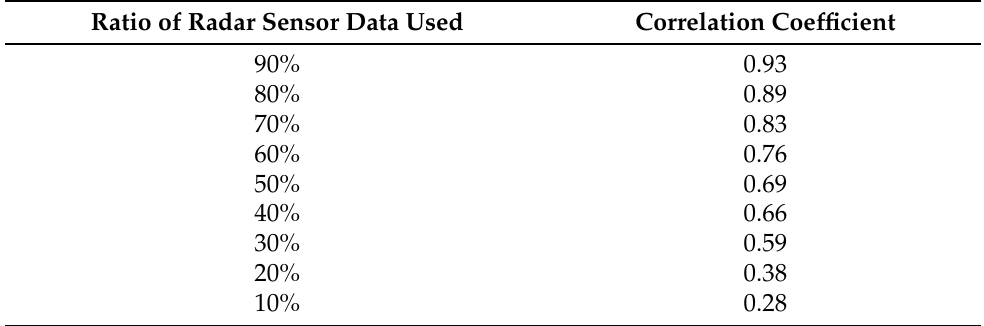
Table 2. Pearson correlation coefficient [28] according to the ratio of the radar sensor data